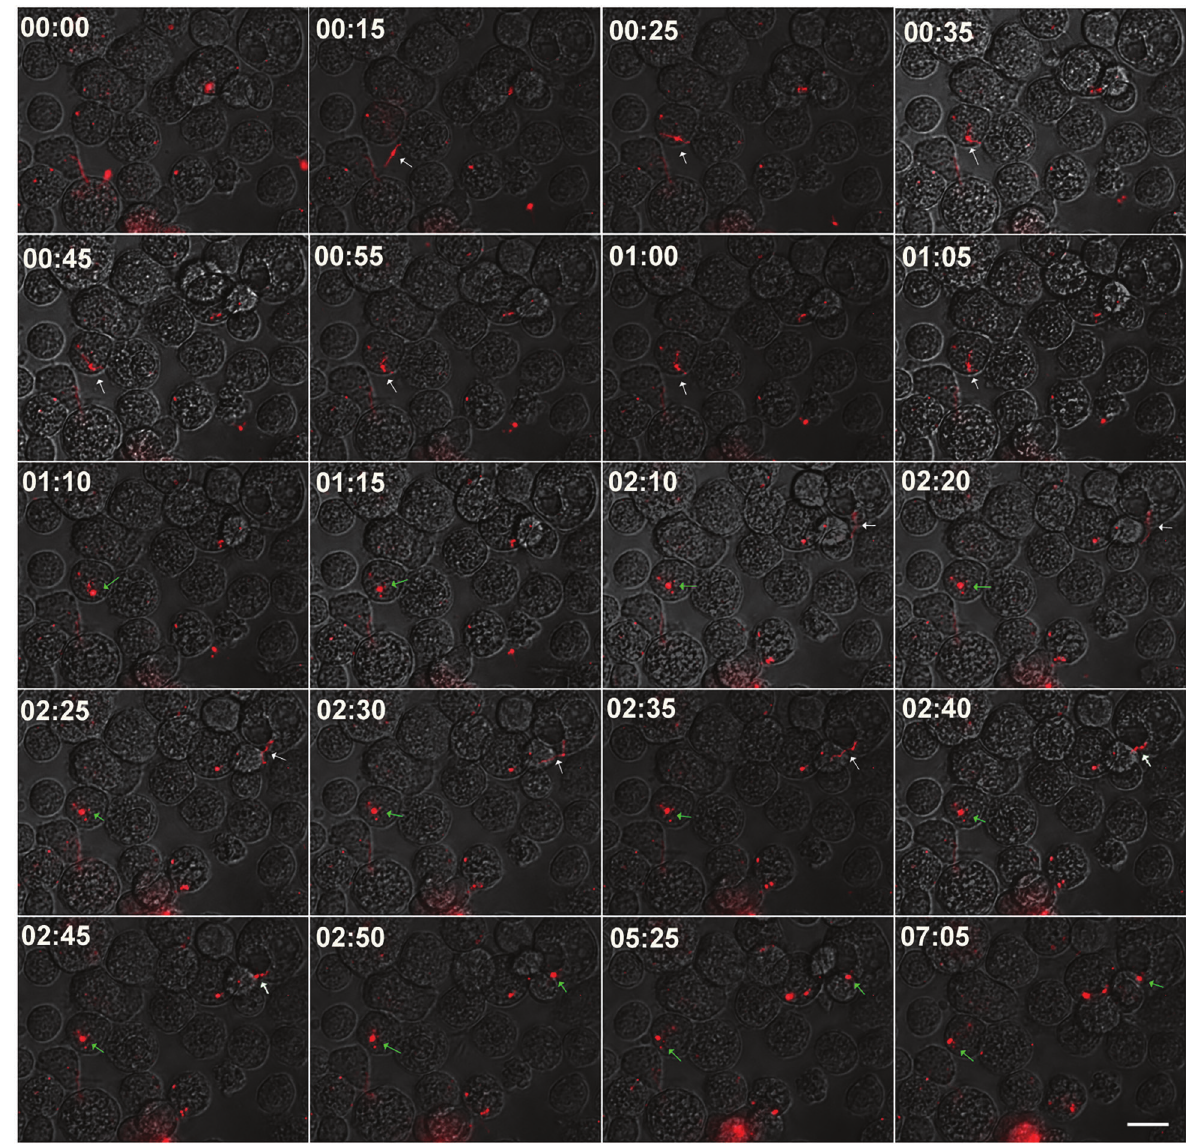
Figure 4. Time-lapse analysis of Borrelia burgdorferi uptake by AVL/CTVM17 cells. PKH26 stained B. burgdorferi were added at a multiplicity of 50 bacteria to each tick cell to a culture of AVL/CTVM17 cells and monitored by time-lapse microscopy during the fi rst 7 h, with a 5 min interval. The selected images show an extracellular B. burgdorferi (white arrow) taking about 50 min to attach to and be internalized by a tick cell (green arrow). The scale bar represents 25 m